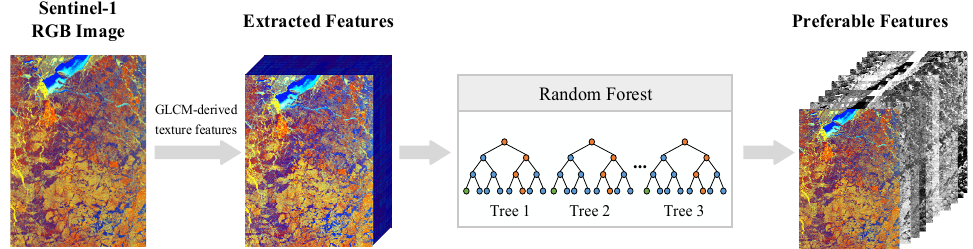
Figure 3. Preferable features of sea ice constituted by polarization features (HH, HV, HH/HV) and the top six GLCM-derived texture features via random forest.